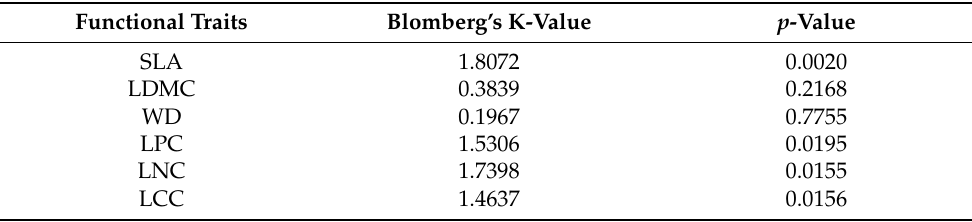
Table 2. Phylogenetic signals of functional traits of investigated plants on Mount Lao. Functional